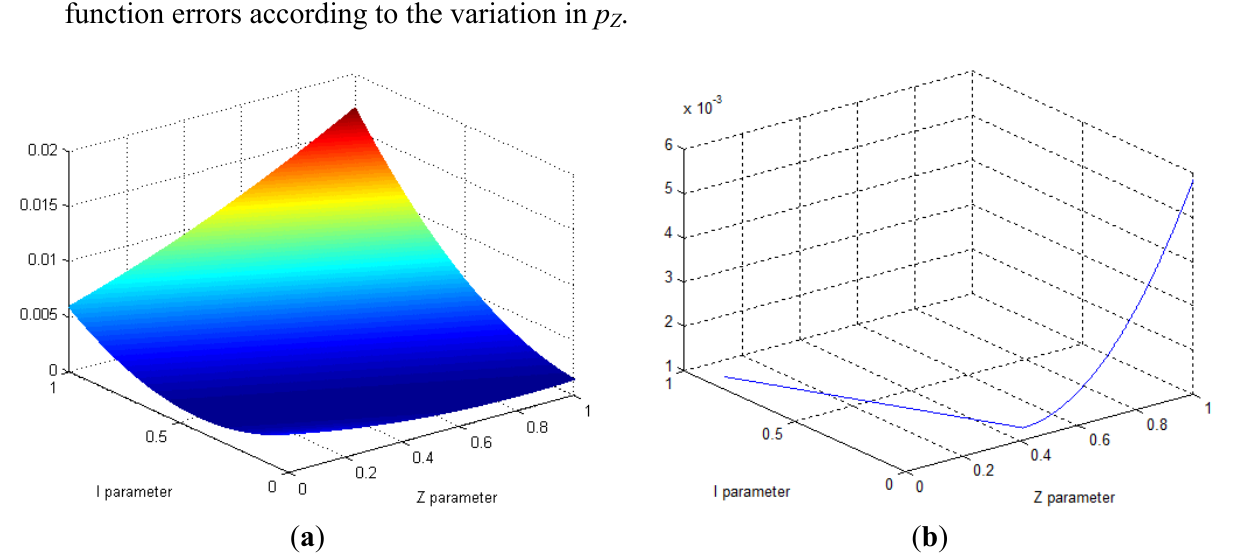
Figure 2. Active power results for the 344th transformer bank on winter evenings: ( a ) errors obtained from the active objective function; ( b ) minimum active objective function errors according to the variation in p Z